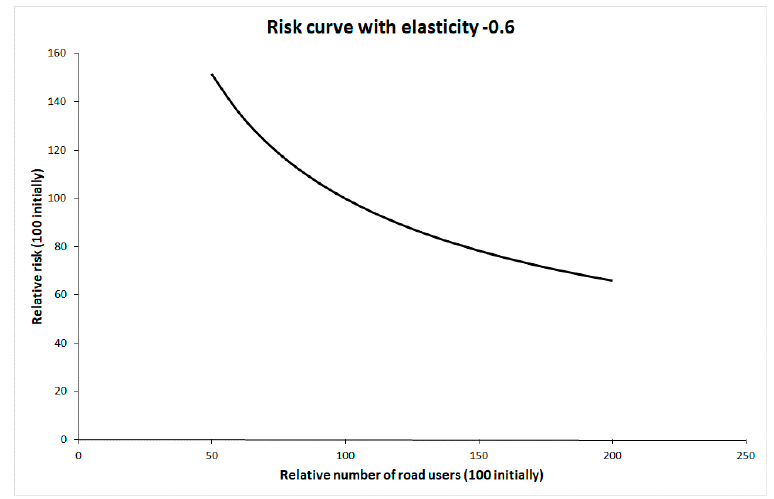
Figure 2. Risk curve with elasticity − 0.6.